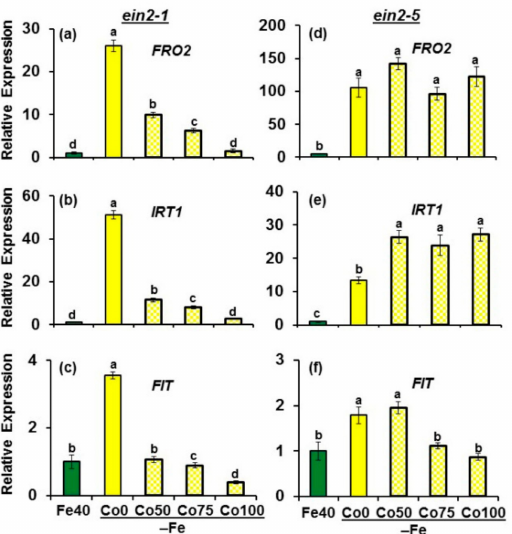
Figure 2. Effect of Fe deficiency and cobalt (Co; an ET synthesis inhibitor) on FRO2 , IRT1 and FIT expression in roots of the Arabidopsis ET insensitive mutants ein2-1 ( a – c ) and ein2-5 ( d – f ). Plants were grown in complete nutrient solution. When appropriate, some of them were transferred during 48 h to complete nutrient solution with 40 µ M Fe-N,N’-ethylenebis[2-(2-hydroxyphenyl)-glycine (Fe-EDDHA) (Fe40) or without Fe (–Fe). Co, at different final concentrations (0, 50, 75 or 100 µ M), was added to the nutrient solution without Fe during the last 24 h. After treatments, roots were collected and kept at − 80 ◦ C for subsequent analysis of mRNA levels. FRO2 , IRT1 and FIT expression were determined. Relative expression was calculated in relation to the Fe40 treatment. Data represent the mean of 3 independent biological replicates ± S.E. Bars with different letters indicate significant differences ( p < 0.05) according to the Tukey’s test.